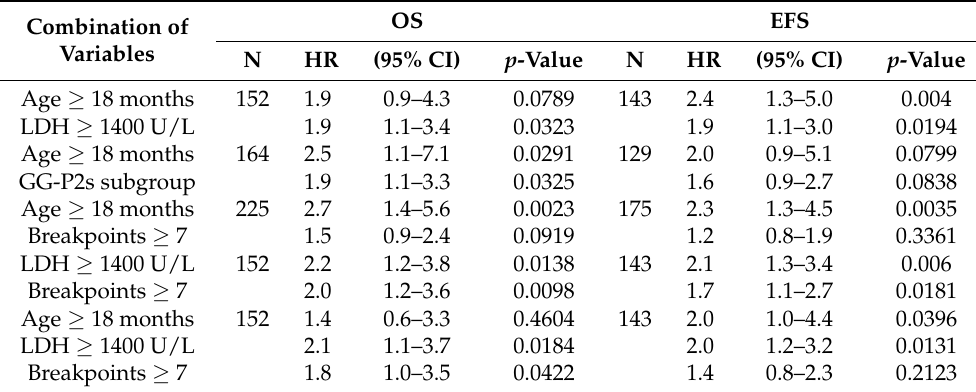
Table 4. Multivariate analysis of OS and EFS according to combinations of variables in stage 4, MYCN non-amplified